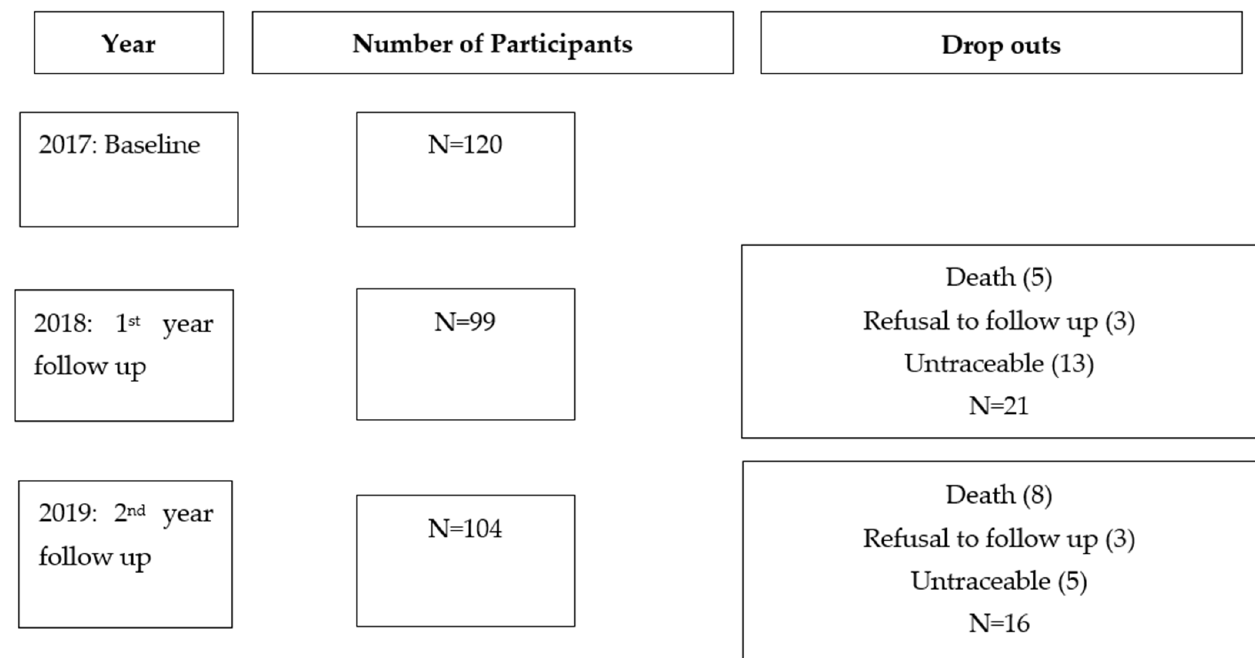
Figure 1. Number of participants per year and drop out reasons. Table 1. Study participants’ characteristics from baseline to 2-year follow-up.